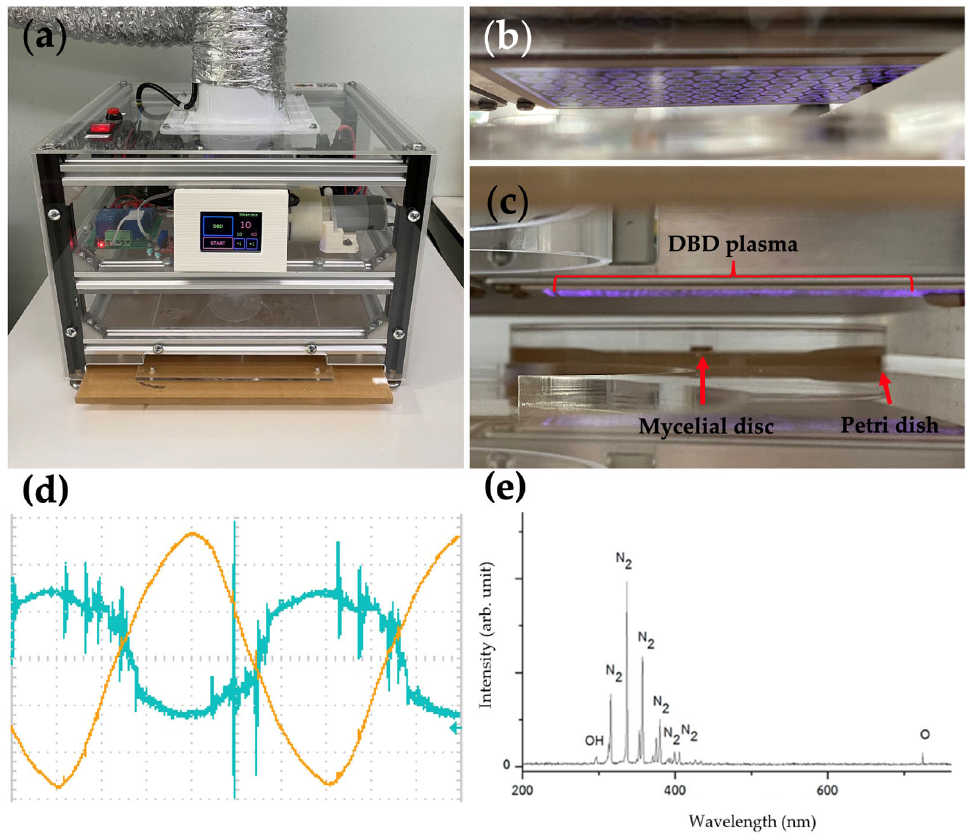
Figure 1. The DBD plasma device and its use in the fungal inhibition experiment: ( a ) DBD plasma device setup; ( b ) DBD plasma-generating discharge plate; ( c ) DBD plasma exposure on a fungal cultured Petri dish; ( d ) V (orange)–I (green) air discharge waveform; ( e ) typical OES of the DBD plasma.